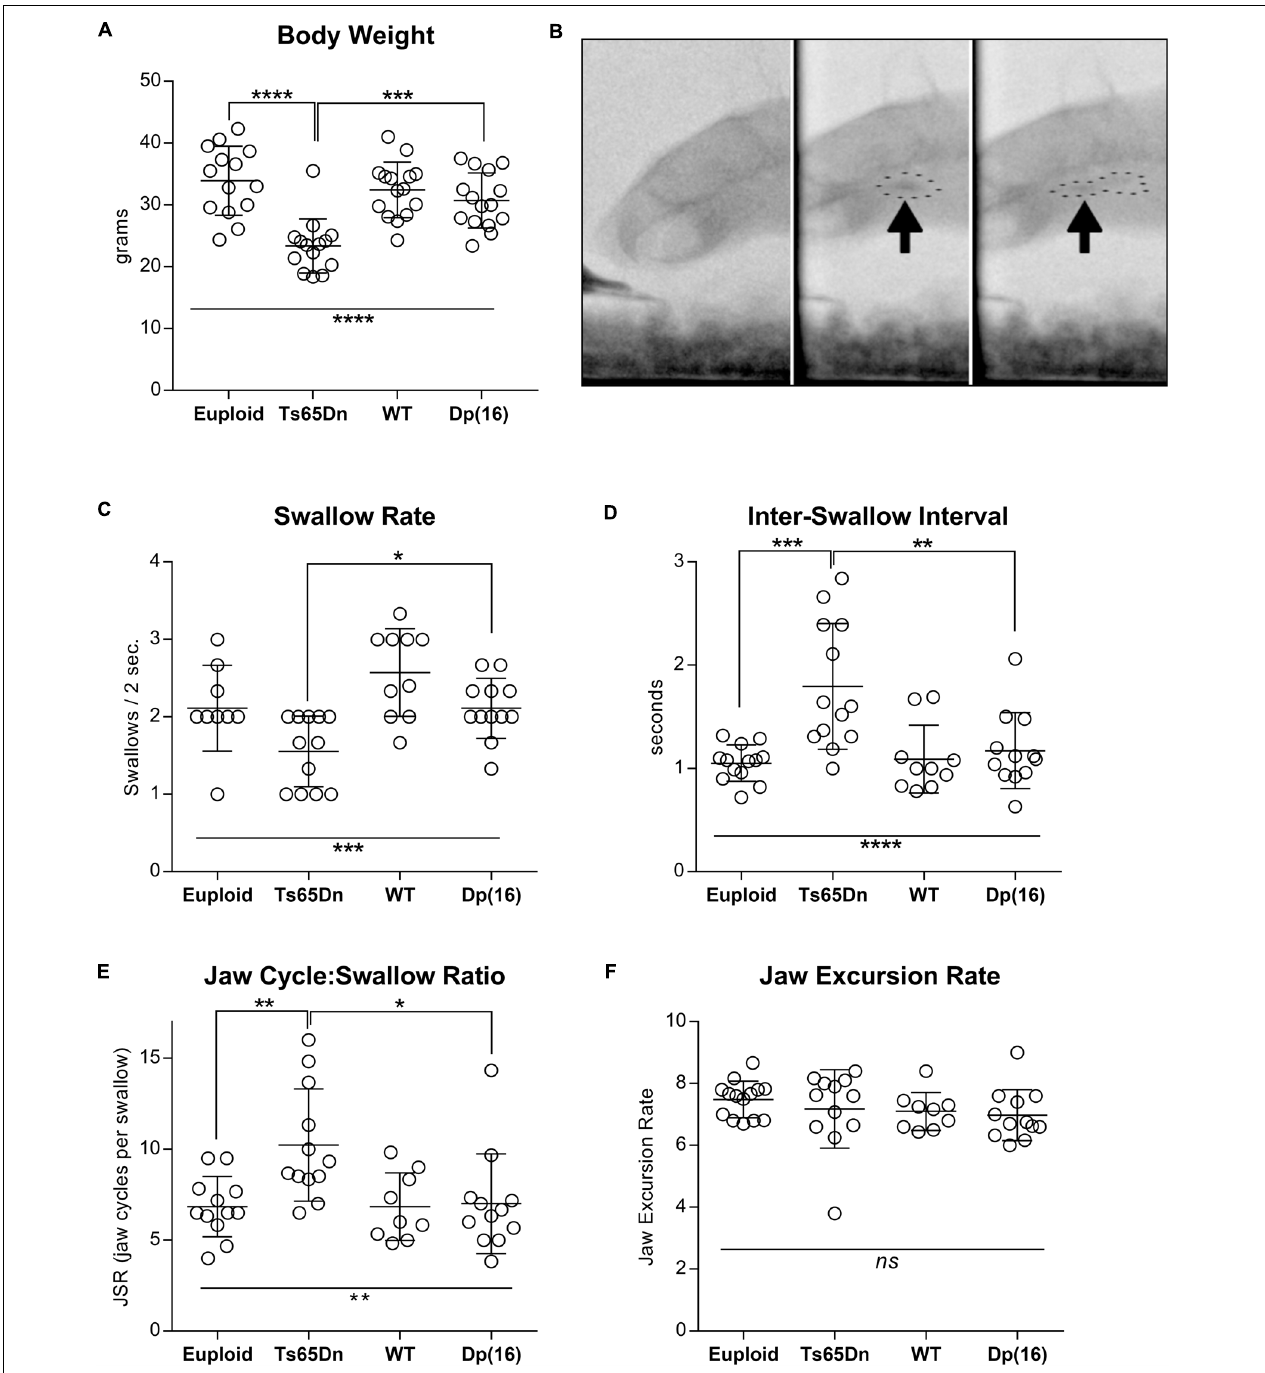
FIGURE 1 | Videofluoroscopic swallow studies analysis in 5-month-old male Ts65Dn and Dp(16) mice. (A) Total body weight of mice analyzed through VFSS. (B) Stills from VFSS footage of adult mice. Arrows and dotted outlines show a food bolus immediately prior to initiation of a swallow (left), and immediately after initiation of a swallow (right). (C) VFSS Swallow rate, (D) VFSS Inter-swallow Interval, (E) VFSS Jaw Cycle:Swallow Ratio, (F) Jaw Excursion Rate. Each symbol indicates the average of 3–5 separate iterations for a single mouse. Mean and SD are shown. ∗ p ≤ 0.05, ∗∗ p ≤ 0.01, ∗∗∗ p ≤ 0.001, and ∗∗∗∗ p ≤ 0.0001.